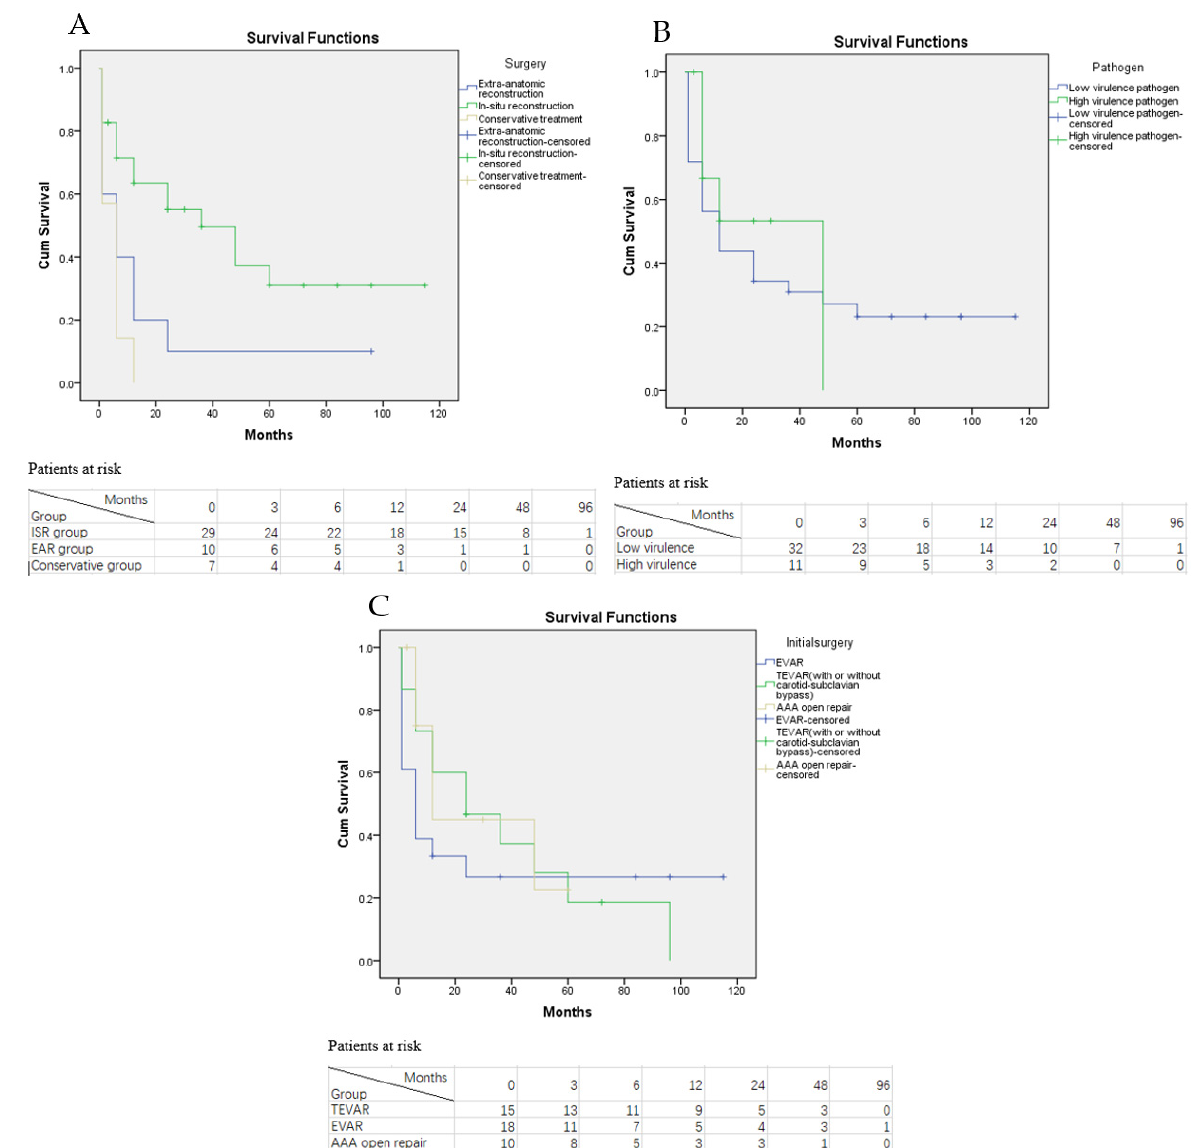
Figure 7. Kaplan-Meier survival curve of overall mortality. ( A ) KM curve of overall mortality grouped by treatment option with the numbers of patients at risk; ( B ) KM curve of overall mortality grouped by the virulence of pathogens with the numbers of patients at risk; ( C ) KM curve of overall mortality grouped by the initial procedure prior to AGI with the numbers of patients at risk.